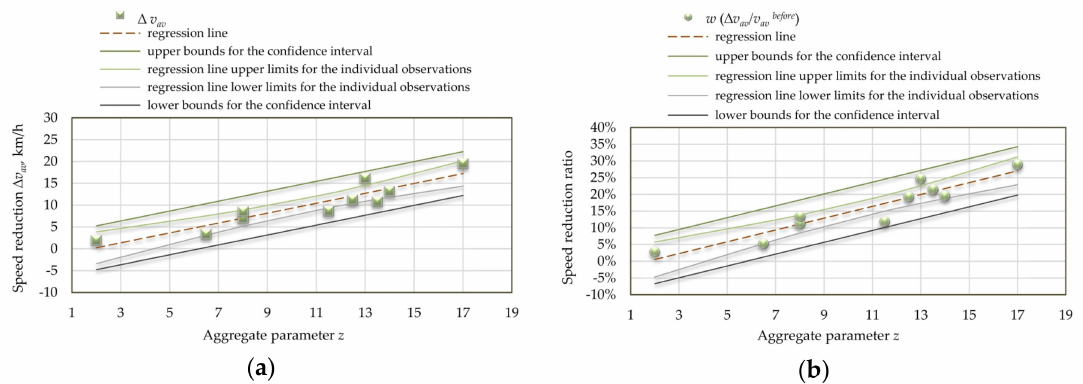
Figure 16. Linear regression function defining the relationship between: ( a ) the free-flow speed reduction ∆ v av and the aggregate parameter z , ( R = 0.92); ( b ) the free-flow speed reduction index w ( v av ) and the aggregate parameter z ( R =